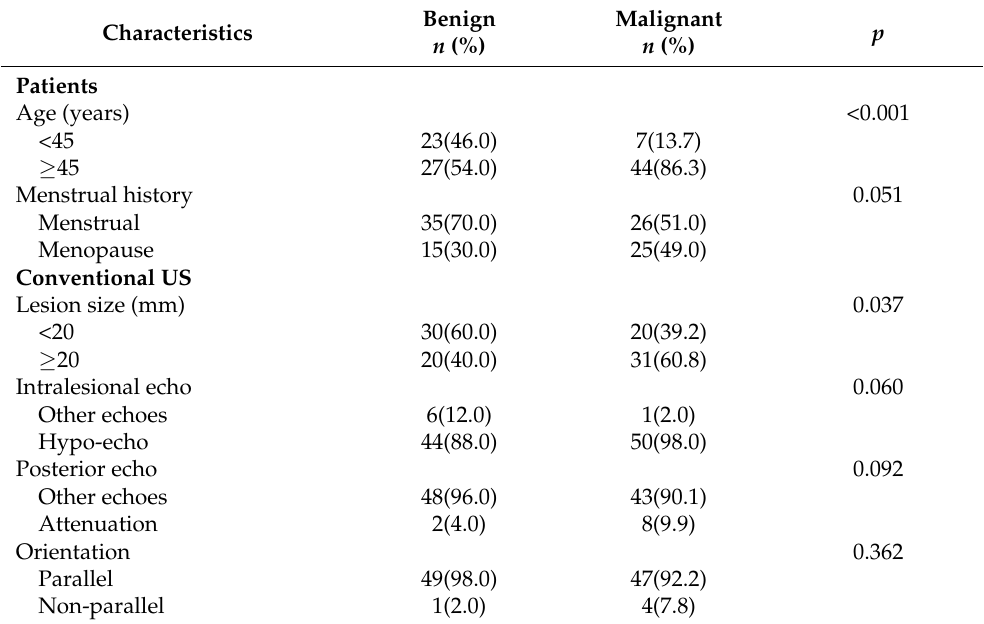
Comparison of clinical information and imaging features between benign and malignant